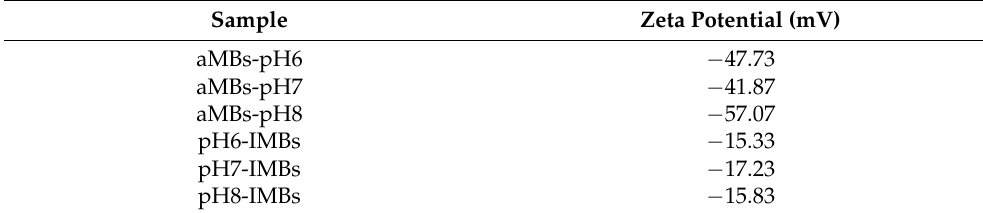
Table 1. The dispersity of aMBs and IMBs.